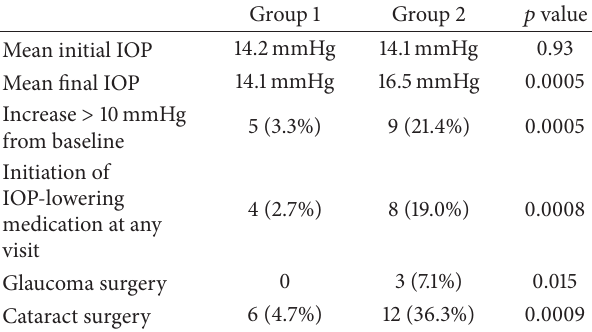
Table 4: Ocular adverse